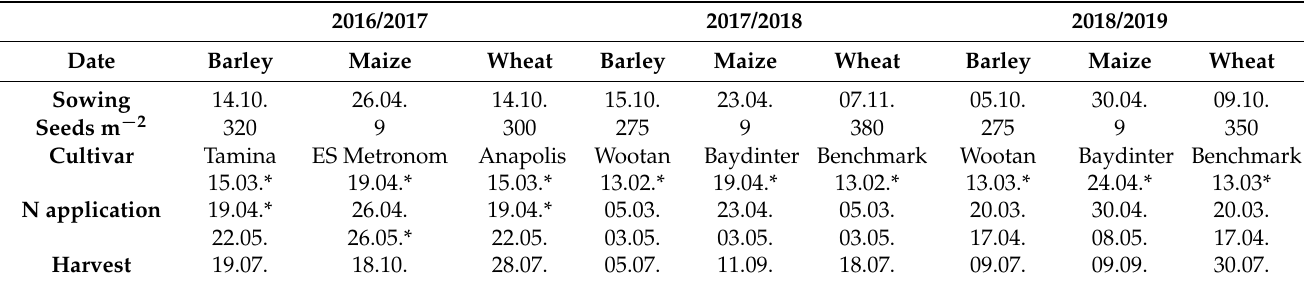
Table 2. Description of sowing, N-fertilisation and harvest for each crop and